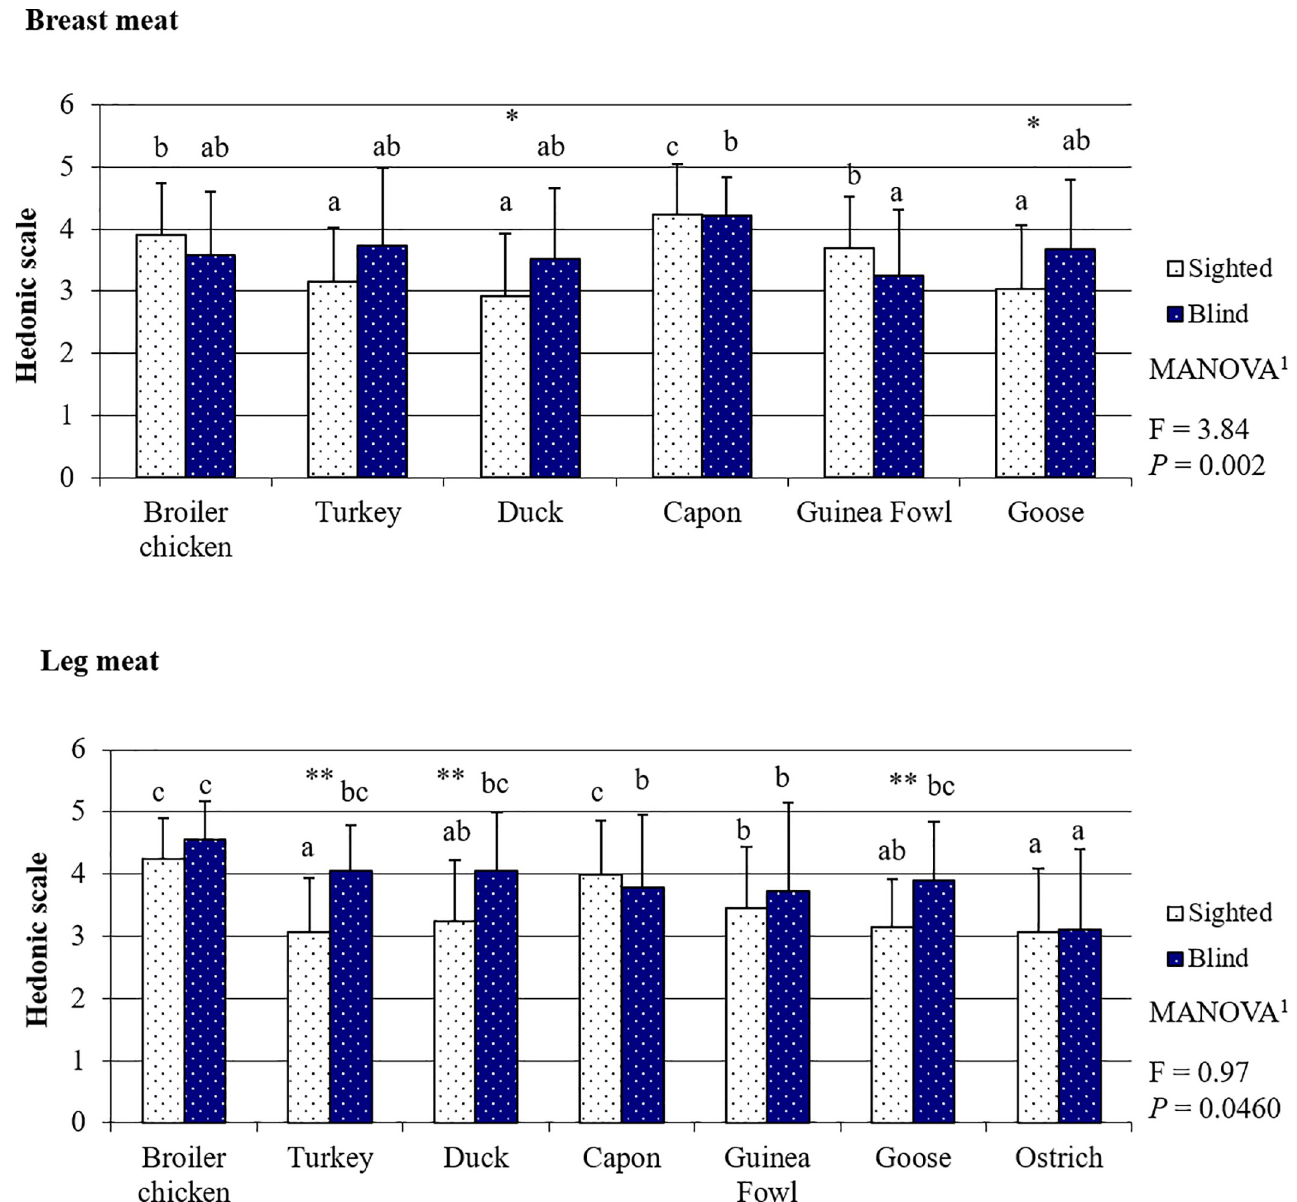
Fig 6. Poultry meat overall liking based on the evaluation by the sighted and blind panelists. panelists to muscles from broiler chicken and capon (all meats P < 0.05), whereas by the blind panelists to muscles from broiler chicken, turkey, duck, and goose. The mean score given by the blind consumers to broiler chicken LM (4.56) was also the highest score in the overall lik- ing assessment in the whole study. Ostrich LM turned out to be the least acceptable in terms of sensory quality by both the sighted and blind panelists. The sighted consumers gave equally low scores to turkey LM and insignificantly higher scores to goose and duck LM ( P = 0.088; P = 0.064, respectively). Compared to the sighted panelists, the blind consumers gave signifi- cantly higher scores in the overall liking assessment to both types of muscles from duck.